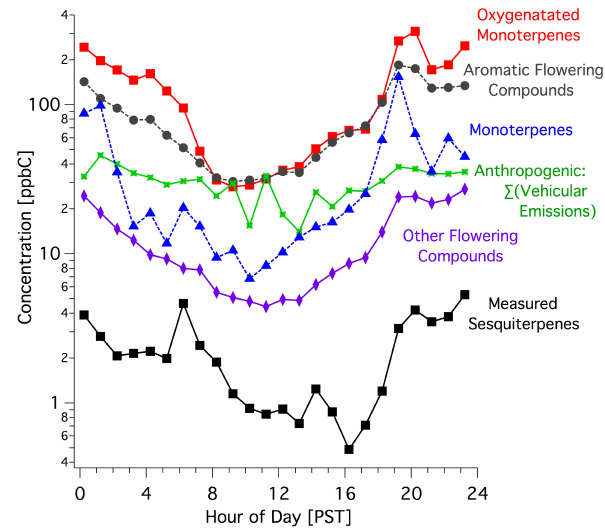
Figure 1. Average diurnal patterns of different compound classes shown on a logarithmic scale during flowering at the Lindcove site. Anthropogenic emissions from motor vehicles are shown for com- parison. Floral emissions of oxygenated monoterpenes and aromat- ics dominate total biogenic emissions. Measured sesquiterpenes are lower than total sesquiterpenes as not all sesquiterpenes could be